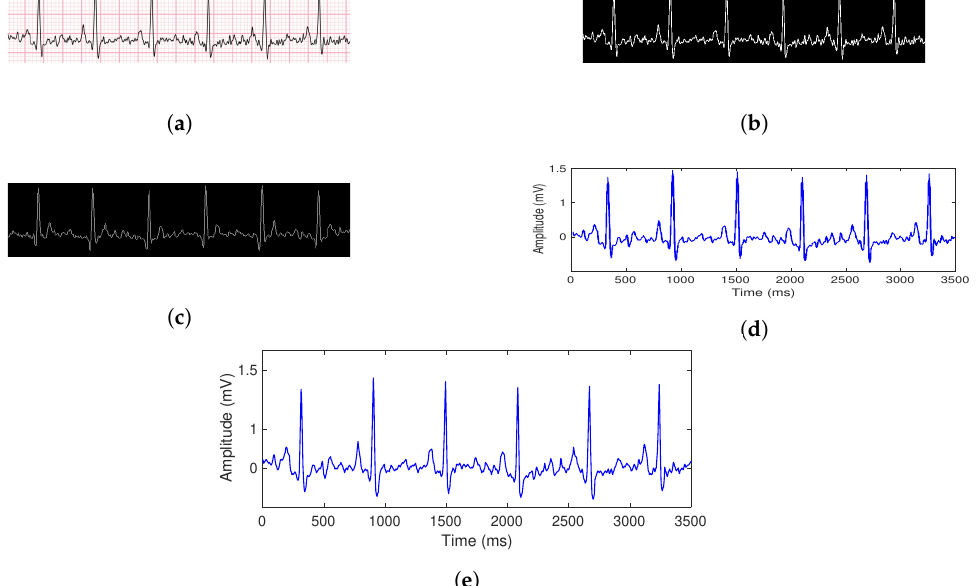
Figure 5. Transformation process of the signal from PDF or JPEG formats ( a ), then a binary mask image is obtained ( b ) and after that, some pixels are removed ( c ). Finally, a shrink operation is applied to capture only useful information ( d ), and then the output digitalized signal ( e ) is